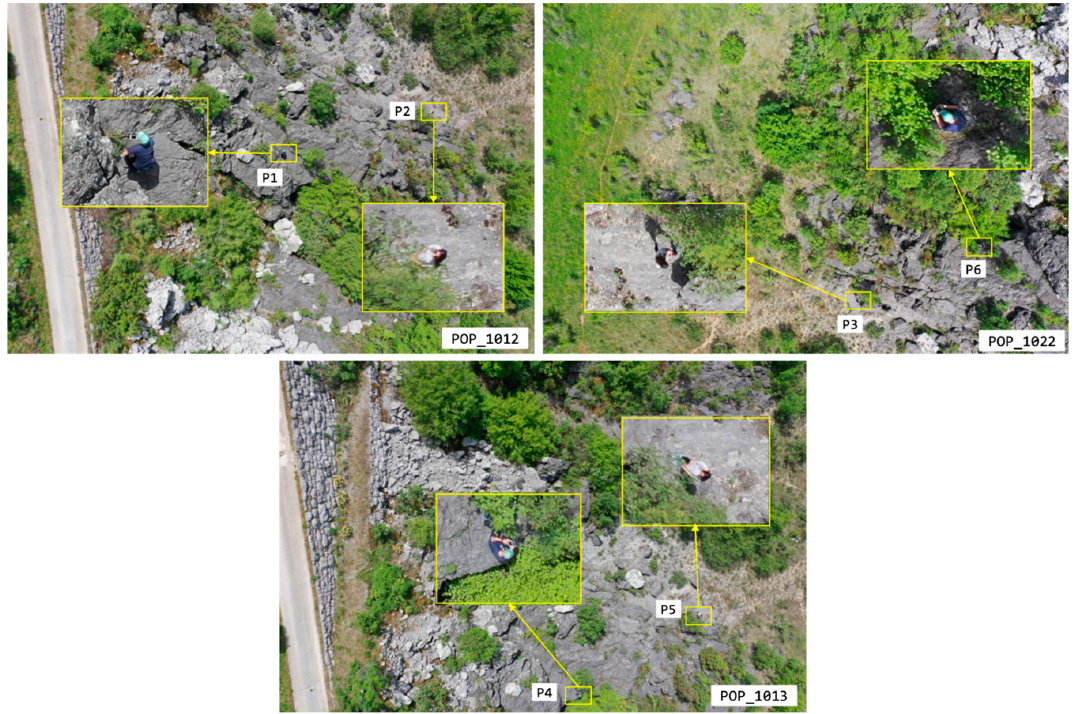
Figure 20. The most difficult examples in missions (mission Popovo polje 1) without support.